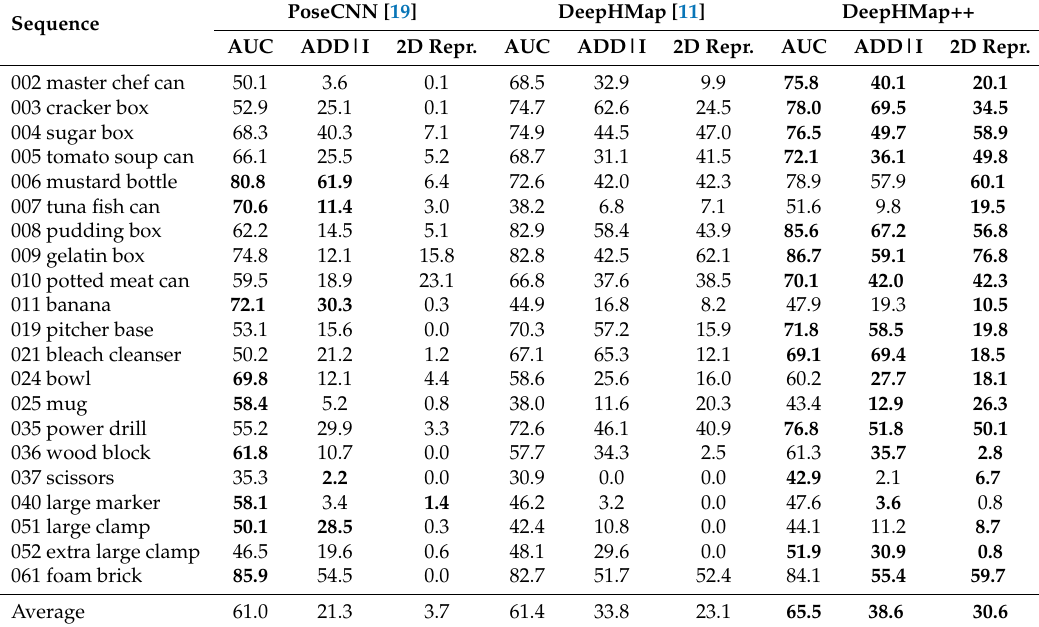
Figure 8. Evaluations on an Occluded LineMOD dataset [6]. The curve represents accuracy vs. pixel threshold in a 2D reprojection error metric. The vertical axis denotes a fraction of correctly estimated scenes. The horizontal axis denotes pixel threshold. Table 3. Comparisons with state-of-the-art methods on YCB-Video dataset [19]. We report the AUC scores, ADD|I and 2D reprojection error for the 21 image sequences of YCB-Video dataset. The best results for each term are shown in